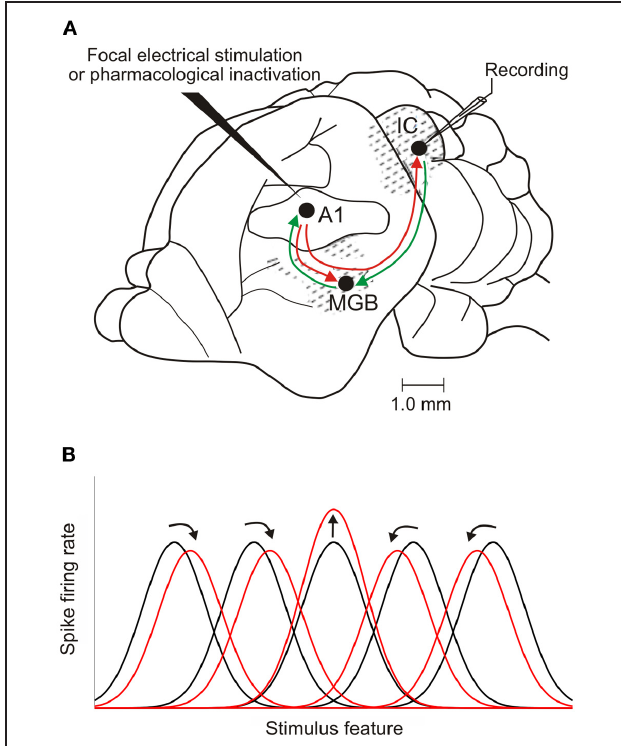
FIGURE 7 | Corticofugal modulation of IC response properties. (A) Lateral view of the brain of a mustached bat, one of the species used most in cortical stimulation and inactivation experiments. The auditory cortex has reciprocal ascending and descending connections with the medial geniculate body (MGB) in the thalamus. It also sends a descending projection to the IC, which, in turn, projects to the MGB. (B) Focal electrical stimulation in the cortex results in facilitation of the responses of IC neurons that have tuning properties matched to those of cortical neurons at the site of the stimulating electrode. The tuning of unmatched IC neurons may shift toward that of the stimulated cortical neurons (as illustrated here), resulting in an expanded representation of the stimulus feature. Shifts in tuning away from that of the stimulated cortical neurons have also been described, compressing the midbrain representation. Adapted with permission from Suga